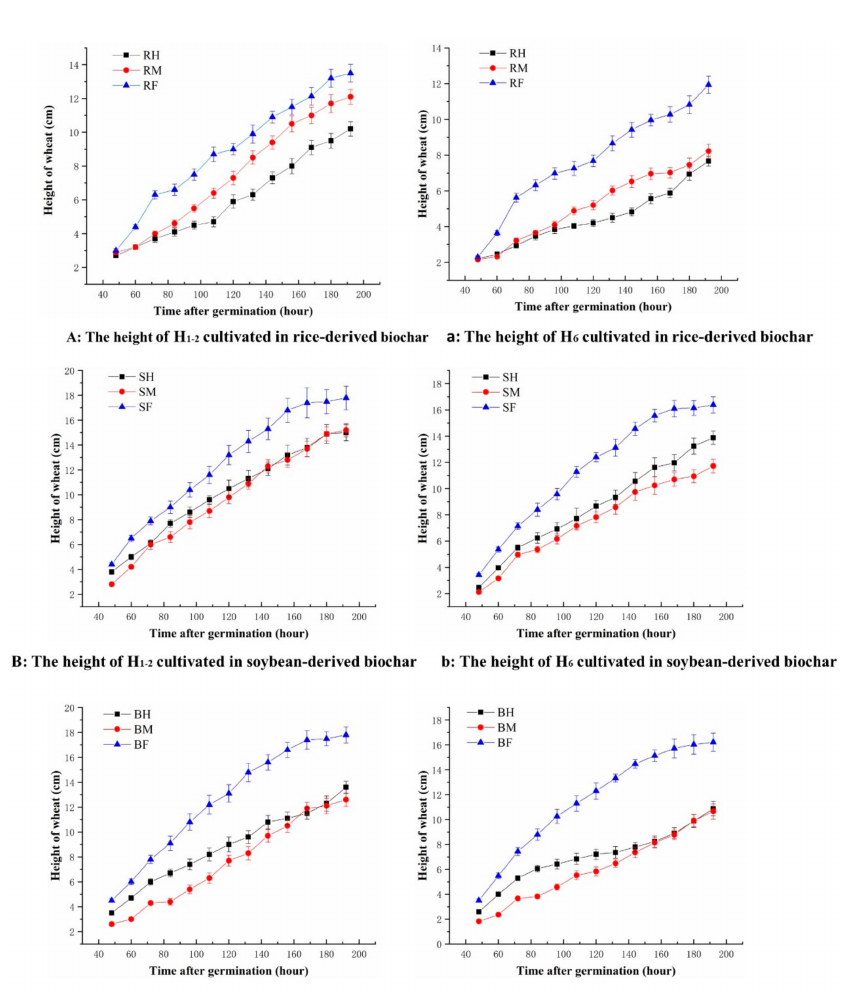
Figure 13. The height curves of wheat plants under different biochar conditions. The heights of H 1-2 are labeled in capital letters; the heights of H 6 are labeled in lowercase